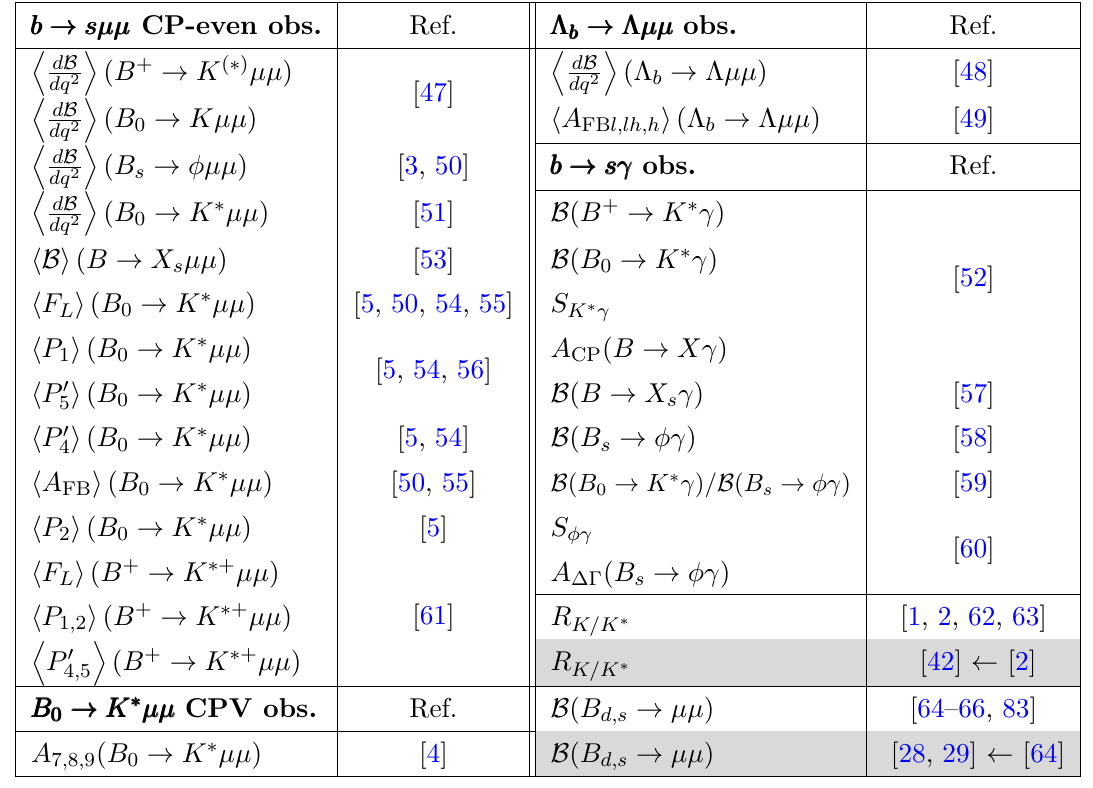
Table 2 . List of the most constraining observables and their measurements implemented in the flavio and smelli Python packages at the date of publication. In the last table line (light gray) we specify the measurements that were updated as of Moriond 2021, and with the notation ← [ . . . ] the measurements [ . . . ] that these updates